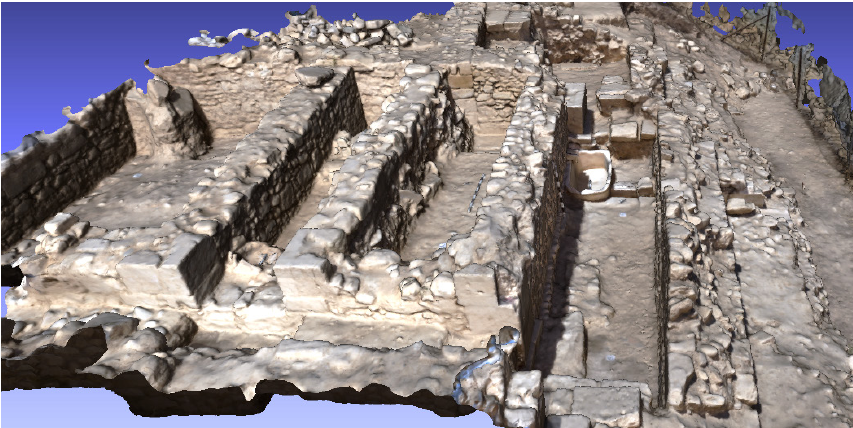
Figure 20. Hadjiabdoulla West complex. Storage and industrial units constructed on the north slope (outside the citadel parapet wall). 3D by V. Tringas (PULP@).